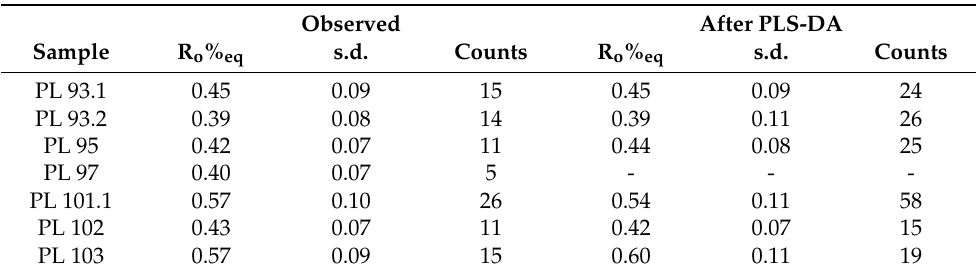
Table 4. Measured vitrinite reflectance equivalent from Raman parameters for each sample before and after PLS-DA